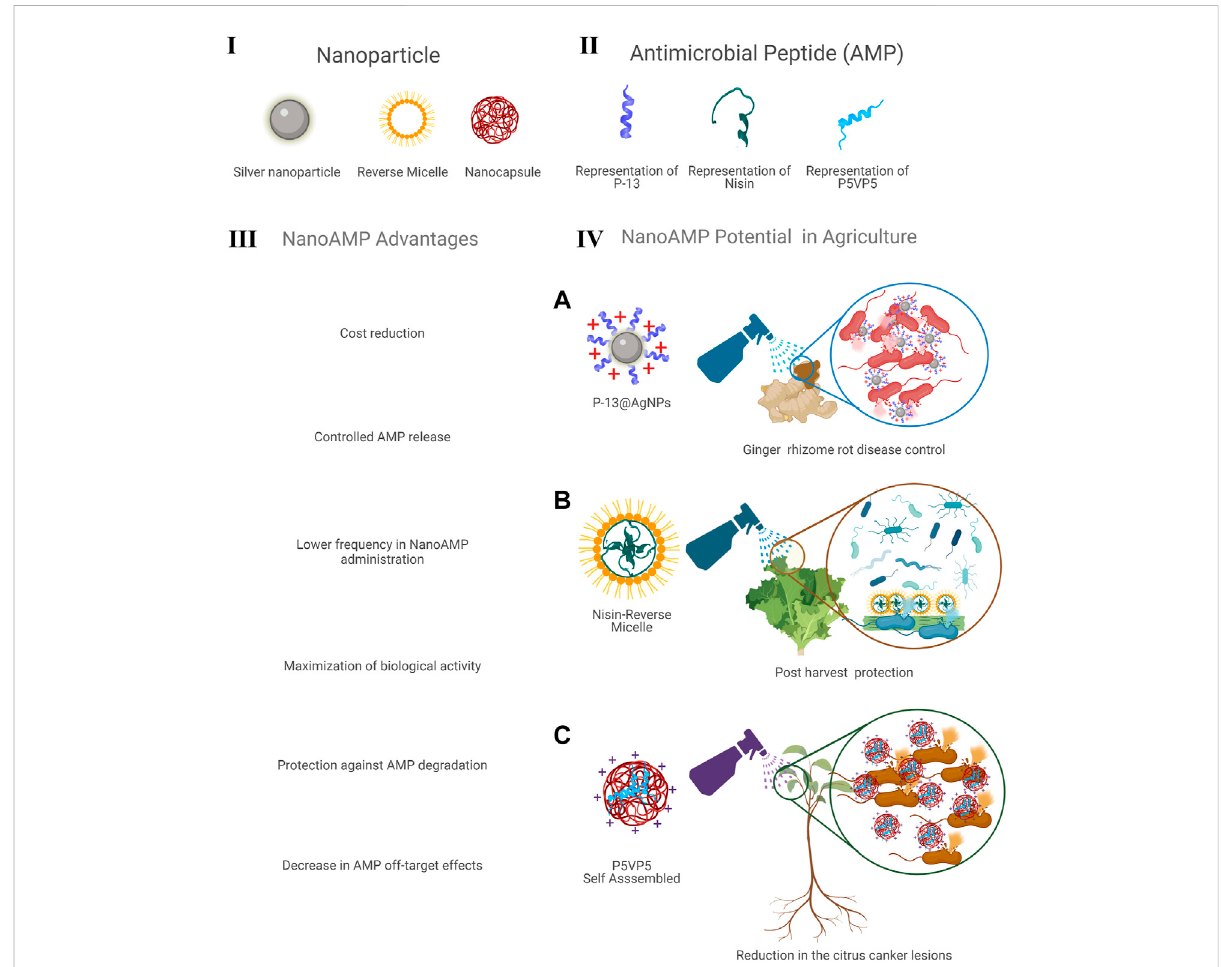
FIGURE 1 NanoAMPs description in which, nanoparticles (I) were associated with antimicrobial peptides (II) showing advantages (III) and potential applications in agriculture (IV). (A) Representation of P13@AgNPs, which presents potential to control ginger rhizome rot disease caused by Bacillus pumilus . (B) Representation of nisin peptide combined with reverse micelles that shows potential for post-harvest food protection. (C) Representation of self-assembled P5VP5 peptide that can be used to decrease citrus canker lesions caused by Xanthomonas axonopodis pv. citri . Figure developed with support of the Biorender